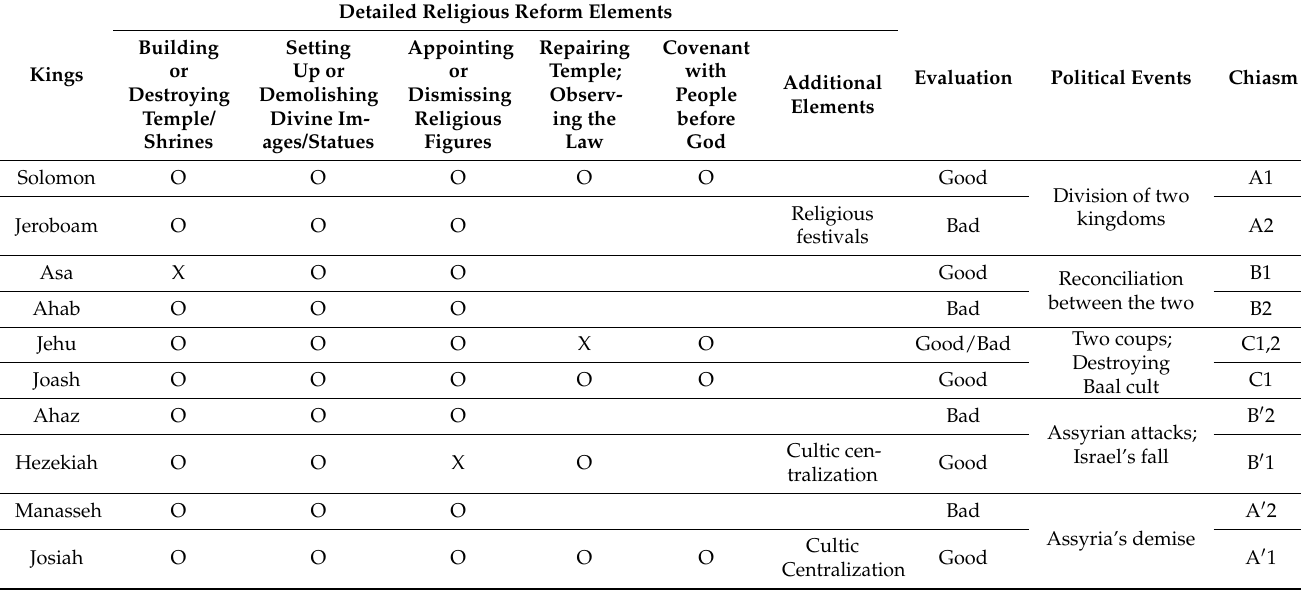
Table 3. Detailed religious reform elements